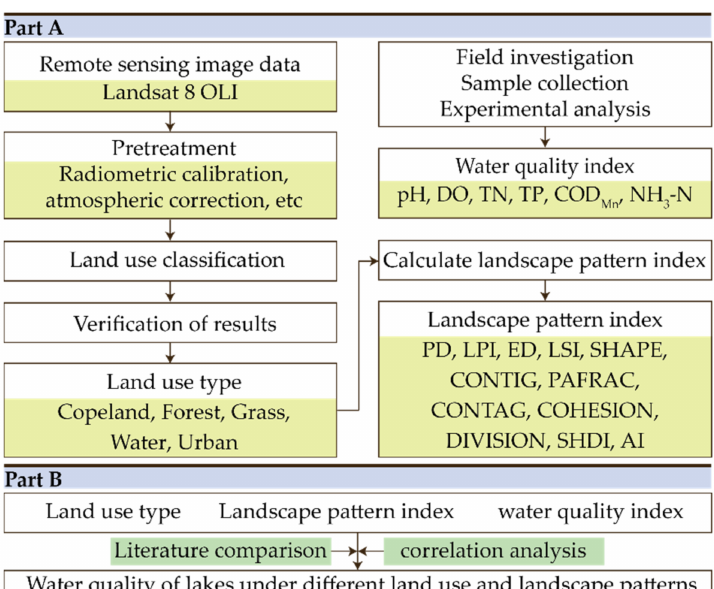
Figure 2. Technical framework. This research was divided into two parts. Part A included data acquisition and processing. The text with background color in the box is the data content required or developed during this step. Part B is the data analysis and discussion, and the text with background color is the